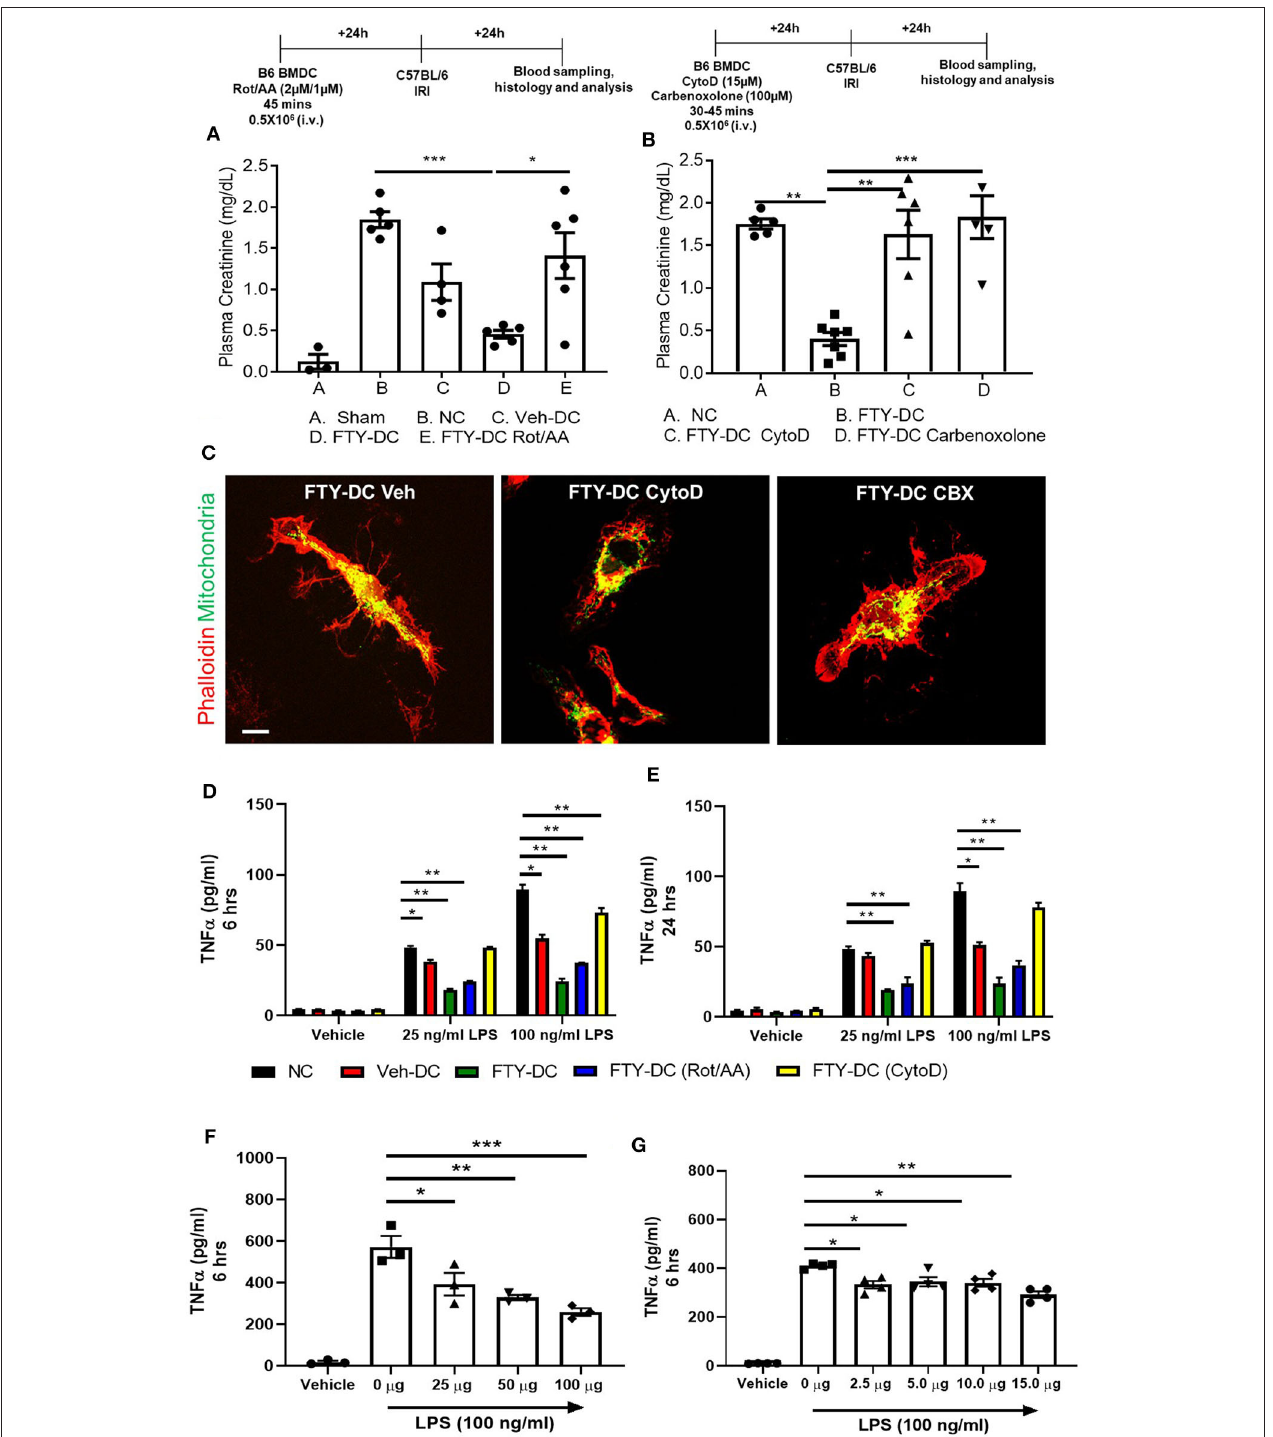
FIGURE 6 | Inhibition of FTY-DC mitochondrial function abrogates protection from kidney IRI. Protocol for experimental setup. (A) Plasma Creatinine (PCr). Mice were i.v. injected with 0.5 × 10 6 DCs (Veh-DC or FTY-DC) and as control no cells (NC) 1 day before bilateral kidney IRI. A group of mice were injected with FTY-DC that were treated with rotenone and antimycin A (Rot/AA). (B) Protocol for experimental setup. Plasma Creatinine (PCr). Mice were i.v. injected with 0.5X10 6 DCs (FTY-DC) and as control no cells (NC) 1 day before bilateral kidney IRI. Two additional group of mice were injected with FTY-DC that were treated with cytochalasin D (Cyto D) or carbenoxolone (CBX). (C) Immunofluorescence of CD11cCrePham fl / fl FTY-DC (green, mitochondria) and labeled with phalloidin (red, actin) that were treated with